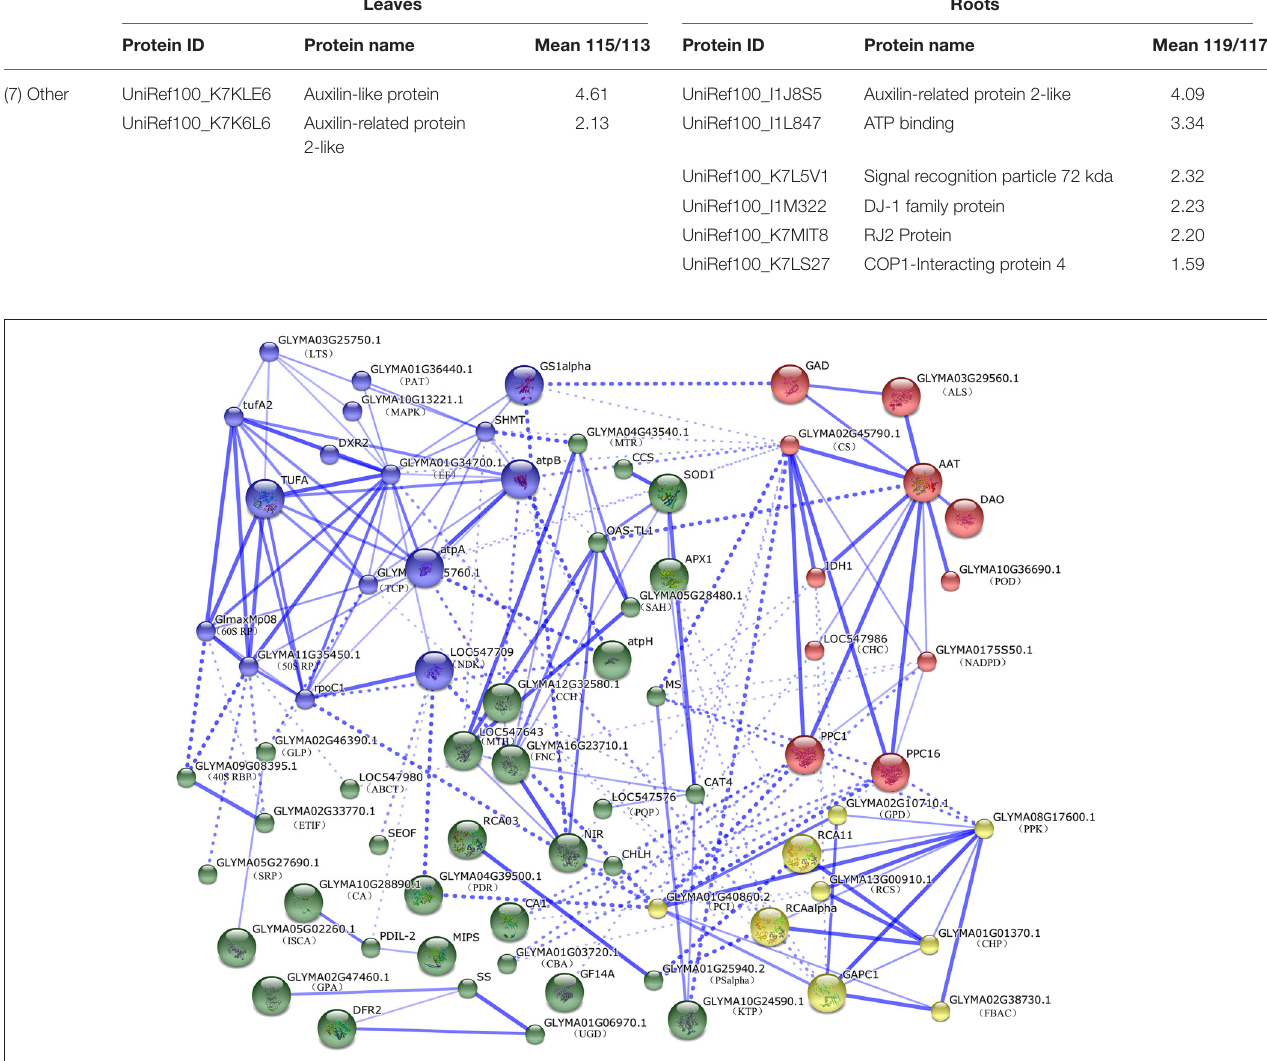
FIGURE 5 | The protein-protein interaction (PPI) network of DEPs in soybean leaves and roots based on STRING analysis. A total of 104 differentially abundant proteins represented by 72 unique proteins from soybean are shown in PPI network. Nodes in different colors belong to four main groups. Stronger associations are represented by thicker lines. Detailed information on protein names and abbreviations can be found in Table